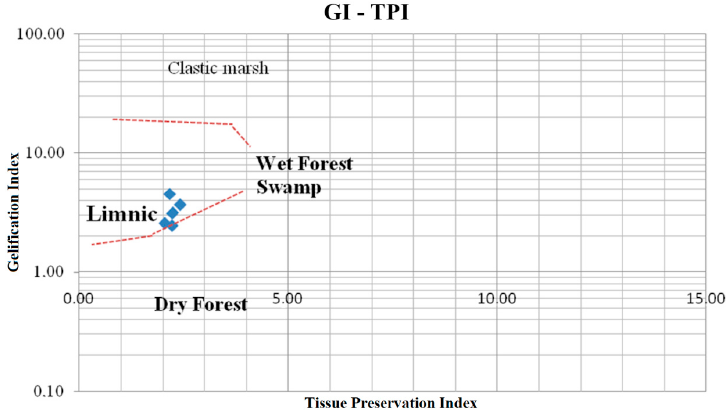
Figure 6. Position of the coaly shales from La Cumbre deposit in Diessel’s facies diagram [31] (modified by Kalkreuth et al. [29]). by Kalkreuth et al.